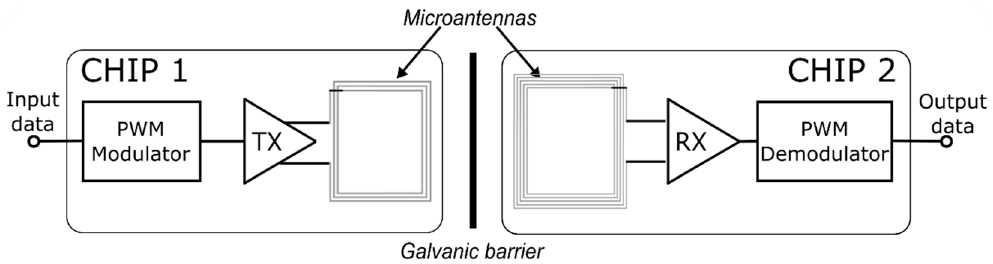
Figure 3. Block diagram of the isolated data channel based on RF planar coupling.